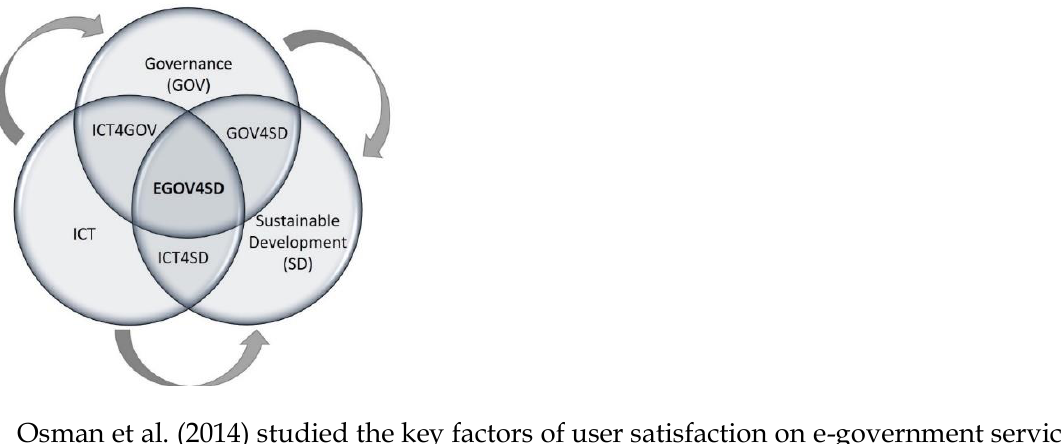
Figure 3: EGOV4SD primary and secondary domains by Estevez and Janowski (2013, p.